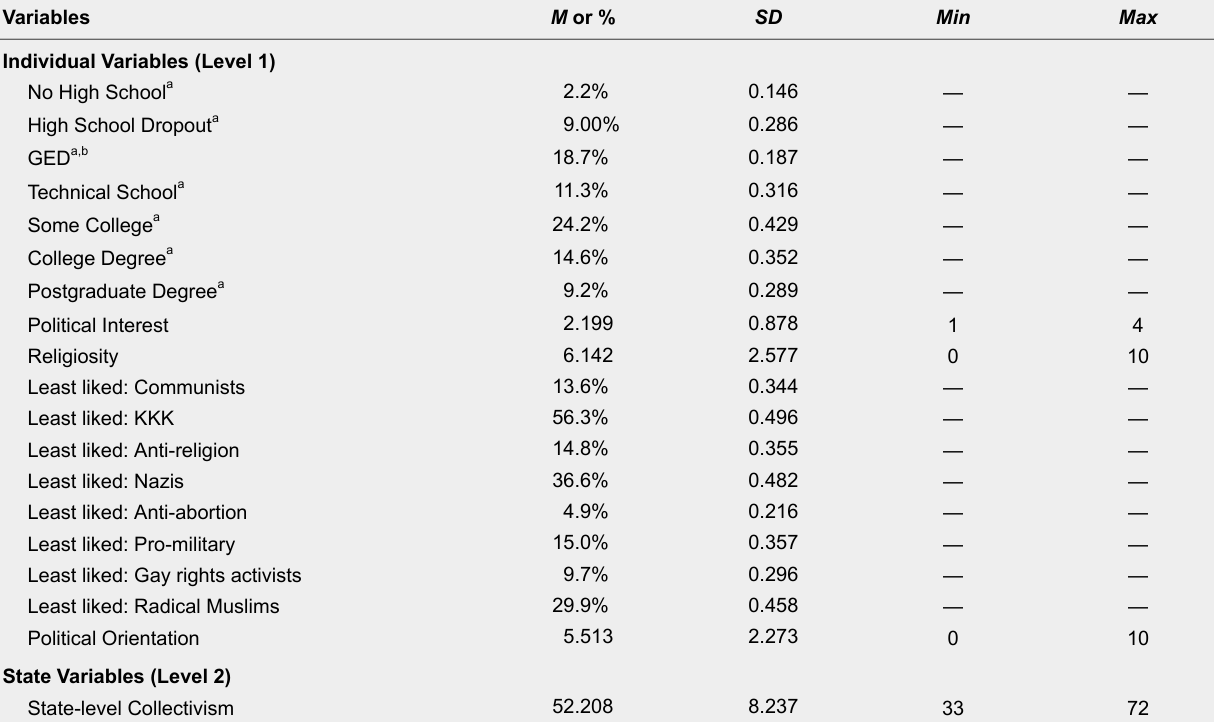
Means and Standard Deviations for Continuous Variables in Multilevel Models Measuring Impact of Individualism/Collectivism and Political Orientation on Support for Free Speech (Study